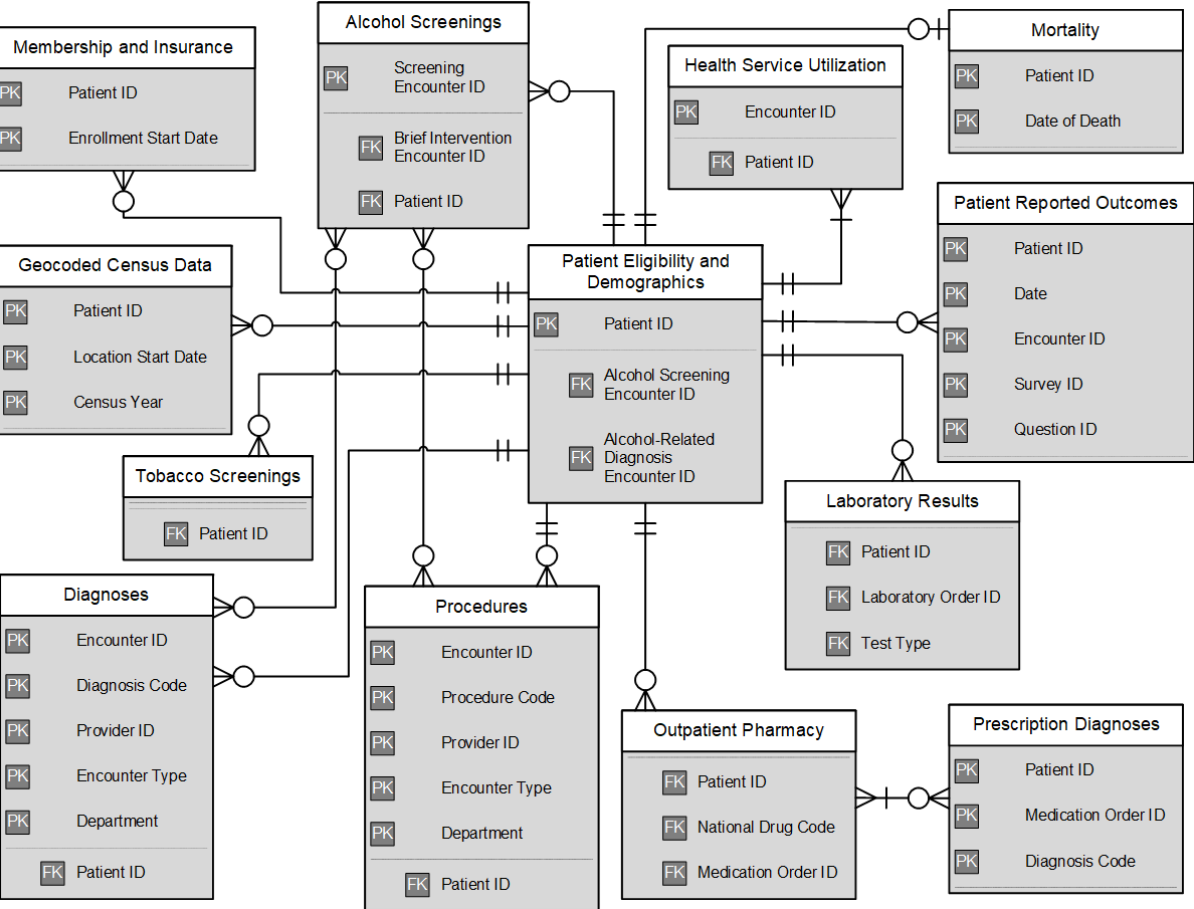
Figure 1. Entity-relationship diagram representing the data structure of core files in the Kaiser Permanente Northern California Adult Alcohol